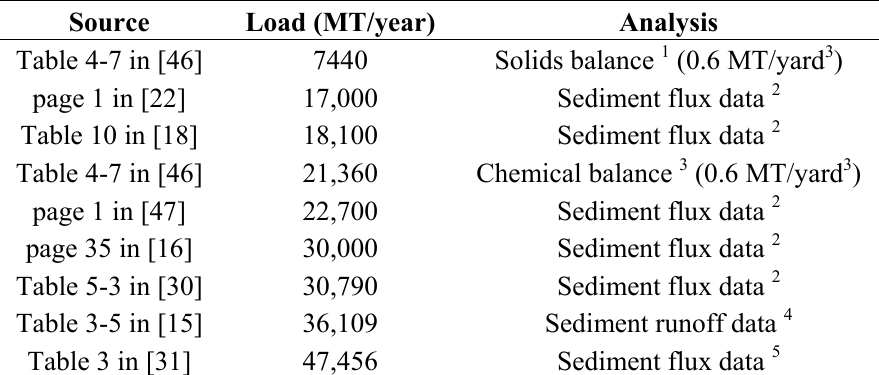
Table 1. Passaic River sediment loading